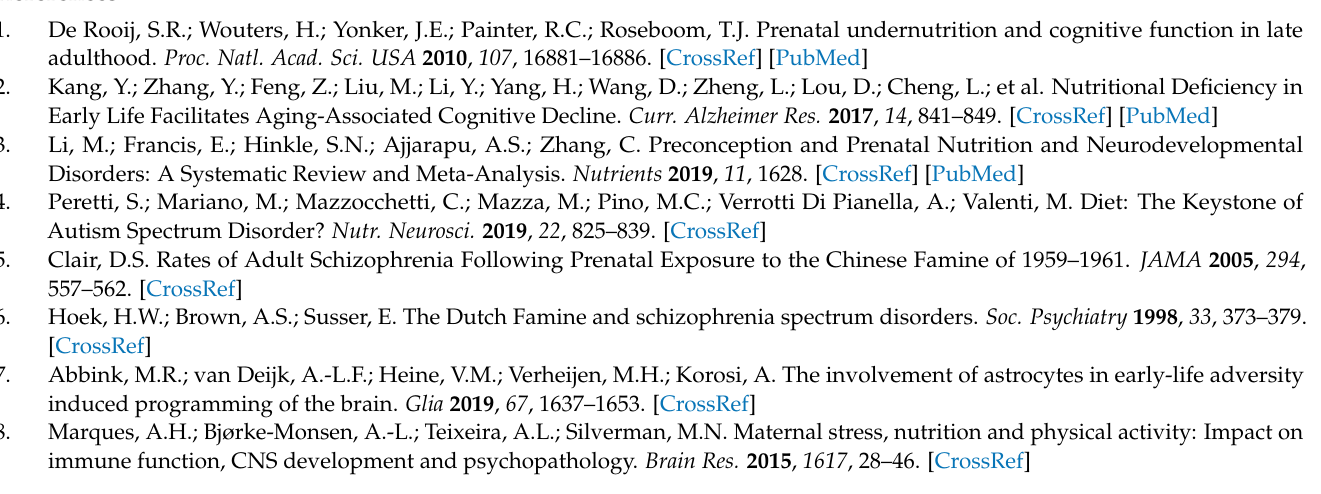
Table S3: DEG from the RNA sequencing, Table S4: DEG celltype overlap; Table S5: DEG IPA; Table S6: WGCNA modules; Table S7: HUB genes WGCNA, Table S8: WGCNA module celltype overlap, Table S9: WGCNA Module IPA, Table S10: Celltype lists, Table S11: Westernblot antibodies, Figure S1: Western blot data on baseline mTOR and P70S6K expression in cerebral organoids, Figure S2: Western blot data of P70S6K phosphorylation after rapamycin exposure of cerebral organoids, Figure S3: Western blot data of P70S6K phosphorylation after AA exposure in cerebral organoids, Figure S4: Variance partition, Figure S5: RNA sequencing Quality control, Figure S6: Volcano plots indicating differentially expressed genes after acute, prolonged, and long-term amino acid exposure, Figure S7: Top three enriched cannonical